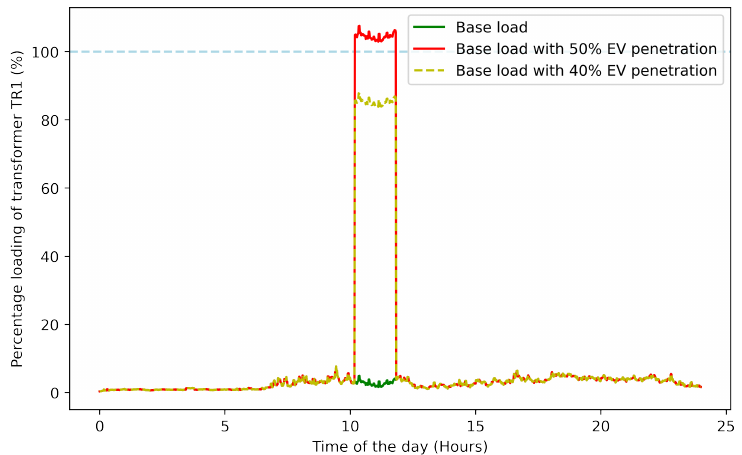
Figure 11. Comparison of transformer loading for different EV penetration scenarios.